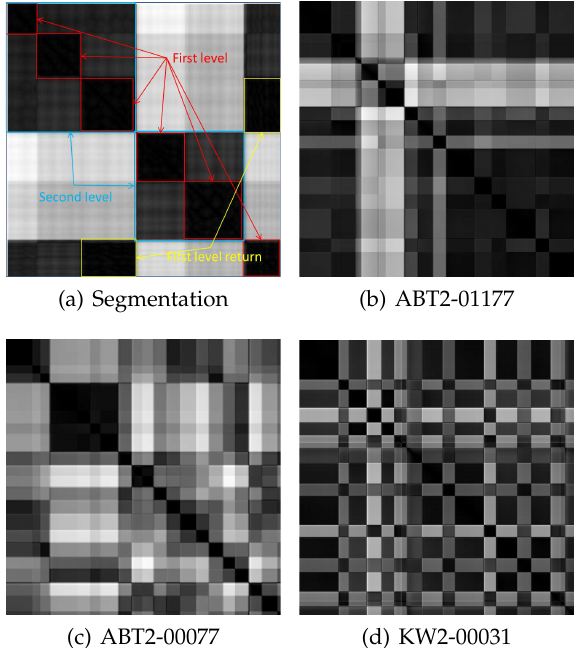
Figure 3 . Hierarchy of sample clusters, first level are fix- ations, second level are clusters of fixations, rectangles of the first off-diagonal represent